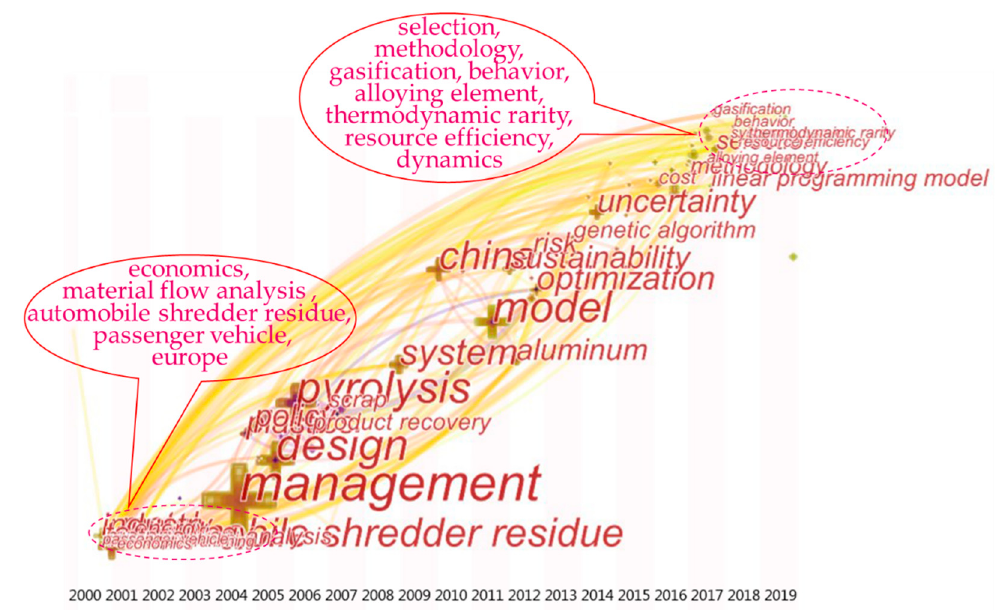
Figure 11. Keywords citation bursts visualization map.